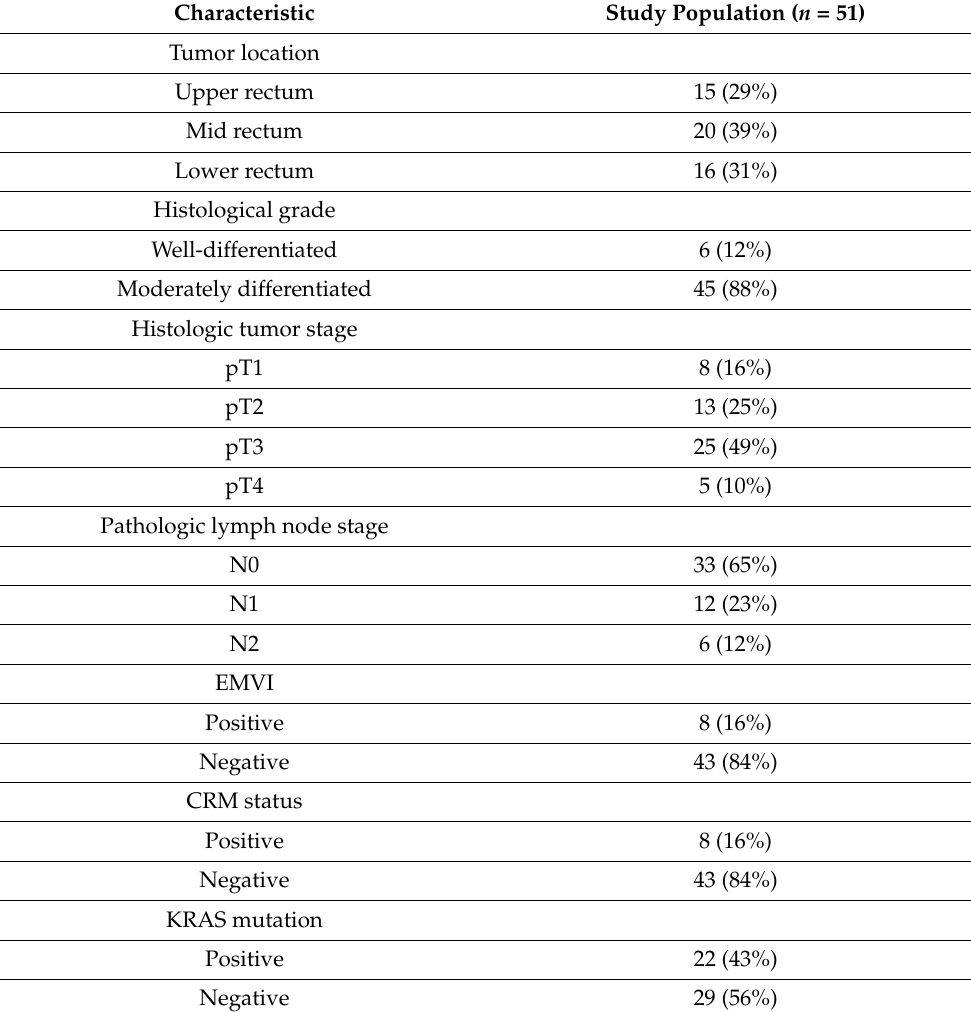
Table 2. Demographic data of the study